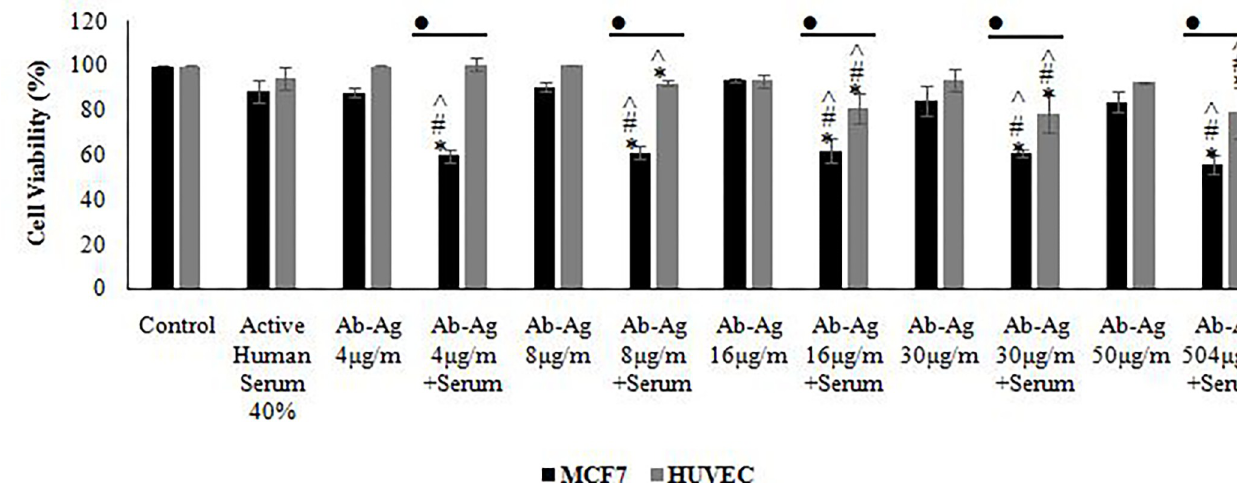
Fig 6. Viability of the MCF7 and HUVEC cell lines after treatment with active serum, antibody conjugated to E . coli antigens and antibody conjugated to E . coli antigens associated with active serum using MTT test. The significant difference in the treatment compared to control group, MCF7 compared to HUVEC, treatment compared to active human serum group and Ab-Ag treatment compared to parallel dose without active serum was shown by using asterisks ( � ), the bullet (•), hashtag (#) and wedge (^), respectively (p <